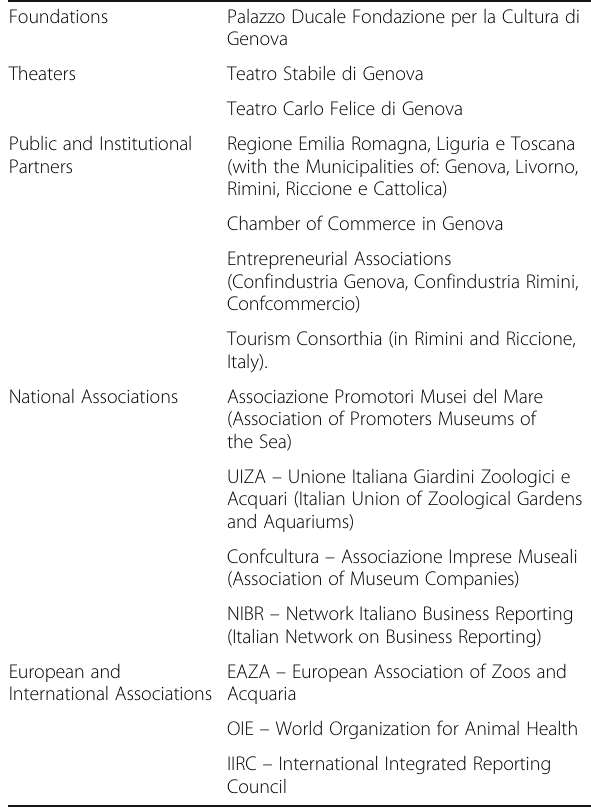
Table 2 Costa ’ s Public and private